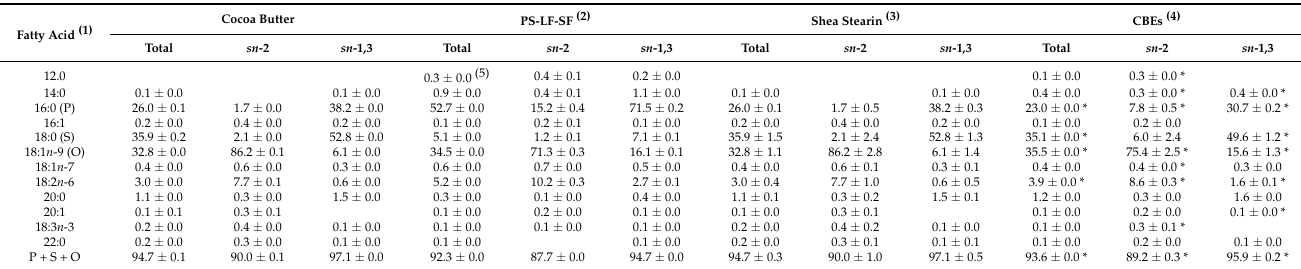
Table 2. Total and positional composition ( w/w %) of cocoa butter, PS-LF-SF, shea stearin, and cocoa butter equivalents